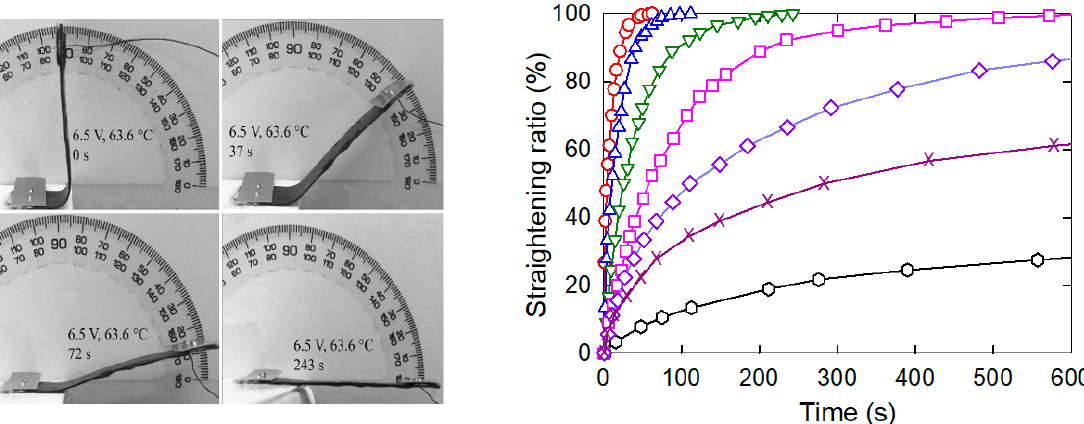
Figure 7. Left : The progress of the straightening of a bent strip over time indicated by green open triangles down in the adjacent plot. Right : The dependence of the strip straightening ratio on time in the course of Joule heating by 7.5 V from the temperature of 25 °C to 76.2 °C (red open circles), to 69.3 °C by 7 V (blue open triangles up), to 63.6 °C by 6.5 V (green open triangles down), to 58.5 °C by 6 V (pink open squares), to 55 °C by 5.5 V (dark blue open diamonds), to 50 °C by 5 V (dark pink X) and to 47.1 °C by 4.5 V (black open hexagons).